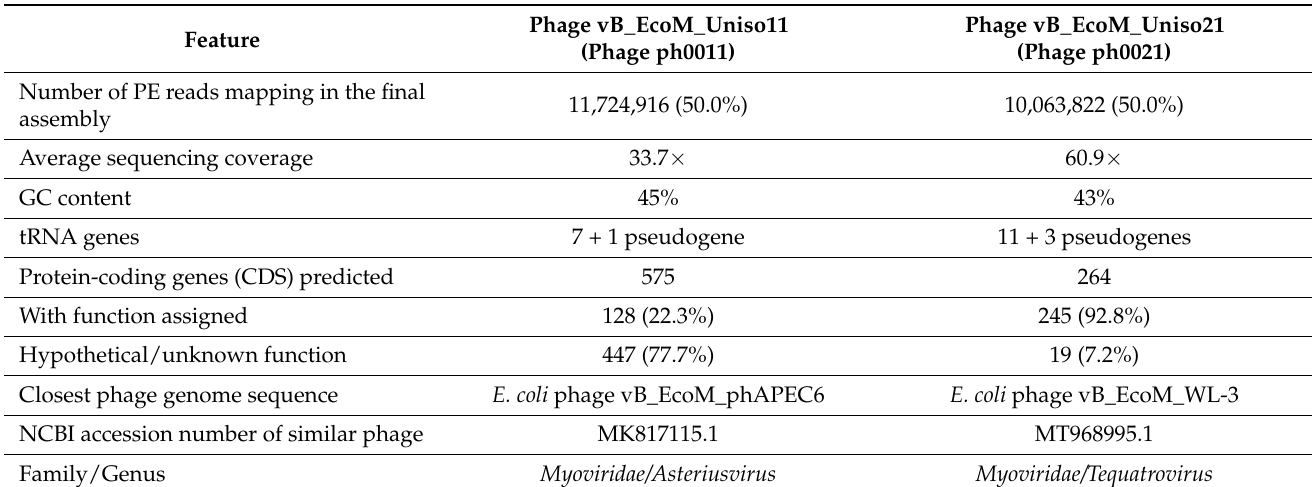
Figure 11. Annotated genome maps of phages ph0011 and ph0021. In these circular maps, predicted CDS, GC skew (+/ − ) and GC content are displayed. The innermost ring indicates the GC skew of phage genome (+, magenta; − , purple), the middle ring indicates GC content (brown) and, in the outer ring, the blue arrows represent the annotated coding sequences (CDSs) according to the an- notation in Supplemental Table S1 and the red arrows represent tRNAs. The direction of the blue arrows represent the direction of transcription (strand + or − ).